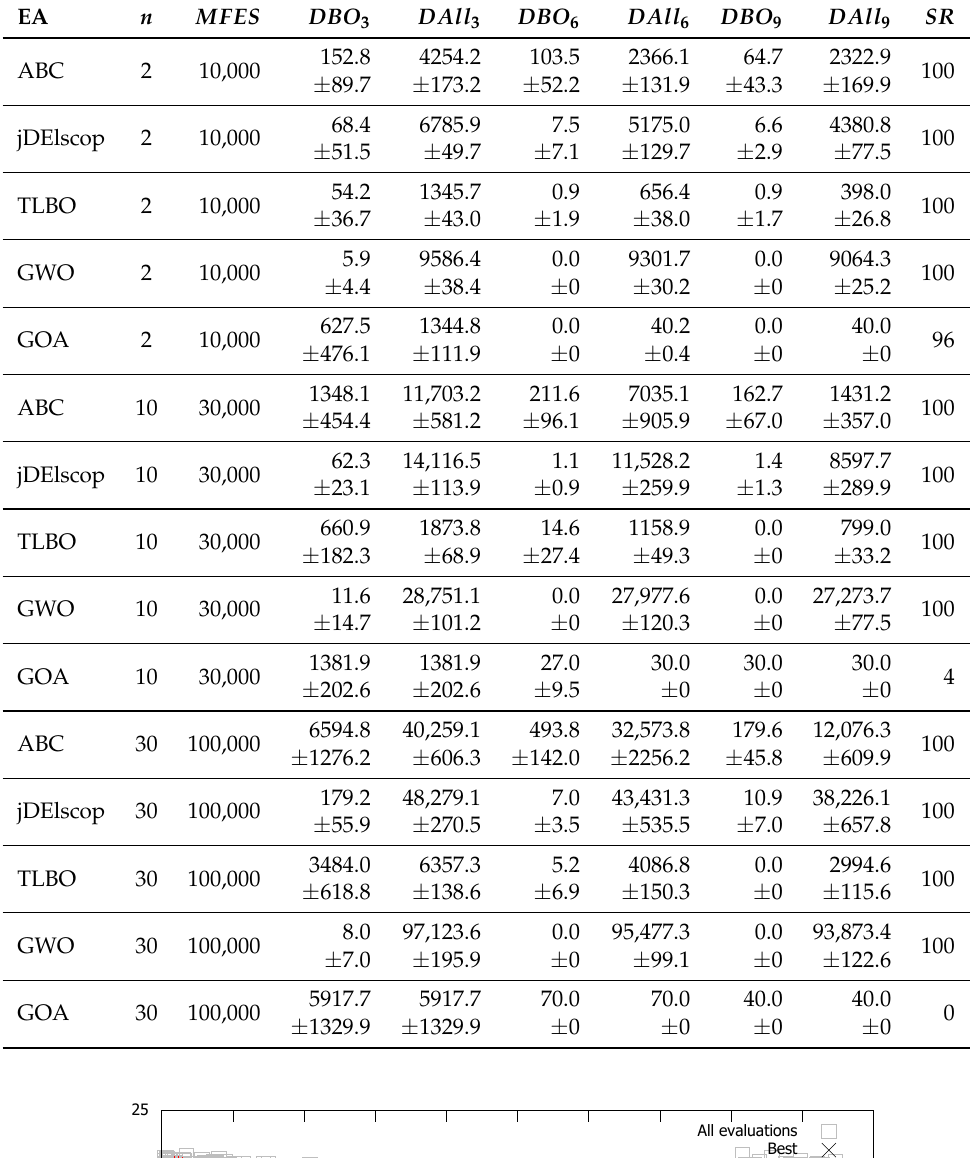
Table 5. Number of duplicate individuals’ evaluation for the Ackley problem.